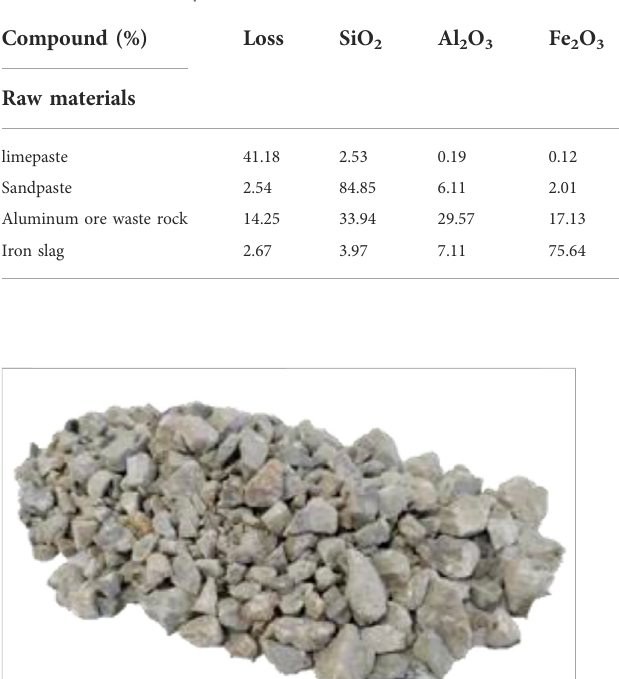
TABLE 1 Chemical composition of raw